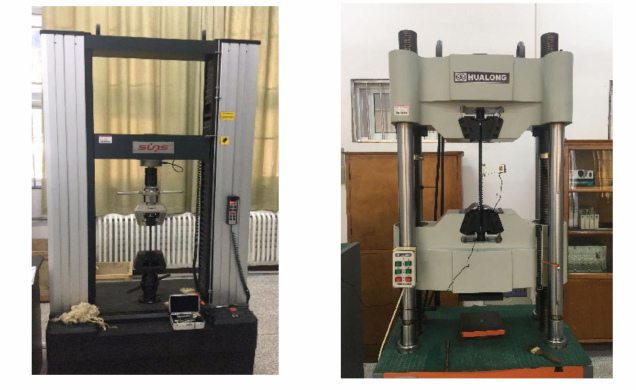
Figure 3. Steel material test.